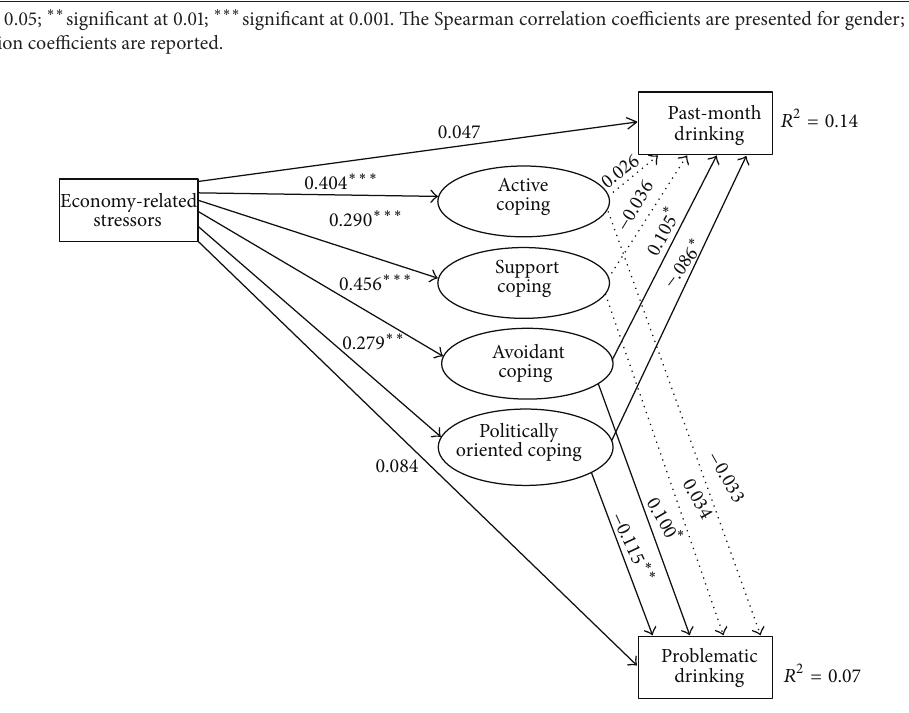
< 0.06; SRMR < 0.08) are used to assess the measurement model. Based on these criteria, there is consistent evidence of good fit for this model (CFI = 0.982; RMSEA = 0.046; SRMR =